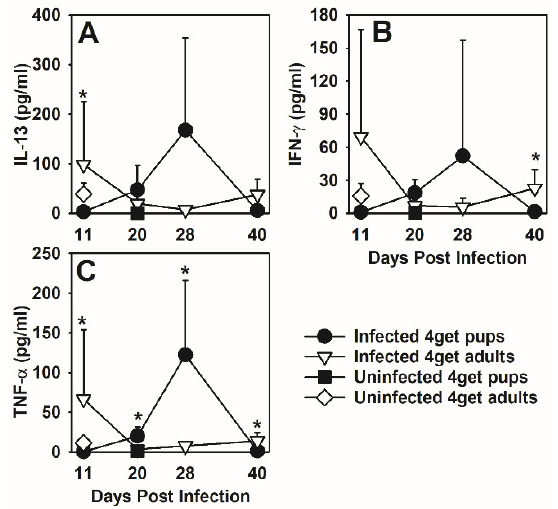
22 of 25 Figure A2. Strain background does not significantly alter clearance kinetics of P. murina in neonatal mice. Two-day-old BALB/c and C57BL/6 pups were infected with P. murina. At indicated days post infection, serum, BALF, and lung lobes were collected from 5–7 mice per group. ( A ) P. murina lung burden was determined microscopically. ( B ) Serum P. murina -specific IgG was determined by ELISA. ( C ) Arginase activity was determined from lung digest lysates as described in materials and